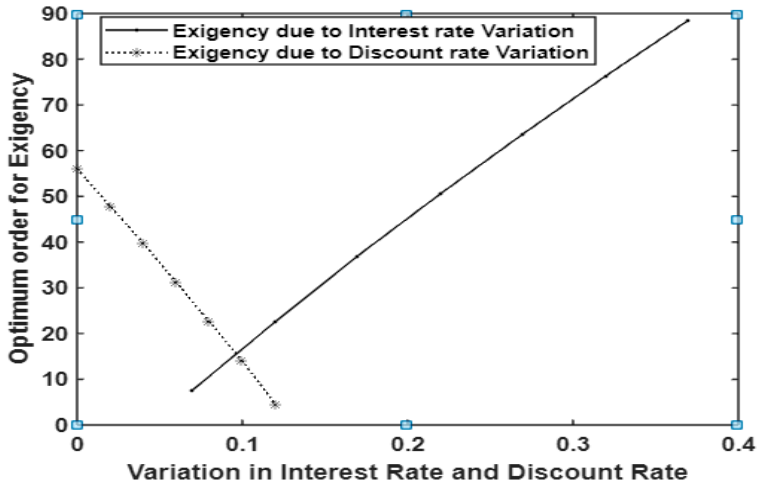
Figure 7. The effect of changes in the interest rate ℐ 𝒫 and discount rate 𝜉 on arriving at optimal order for exigency.